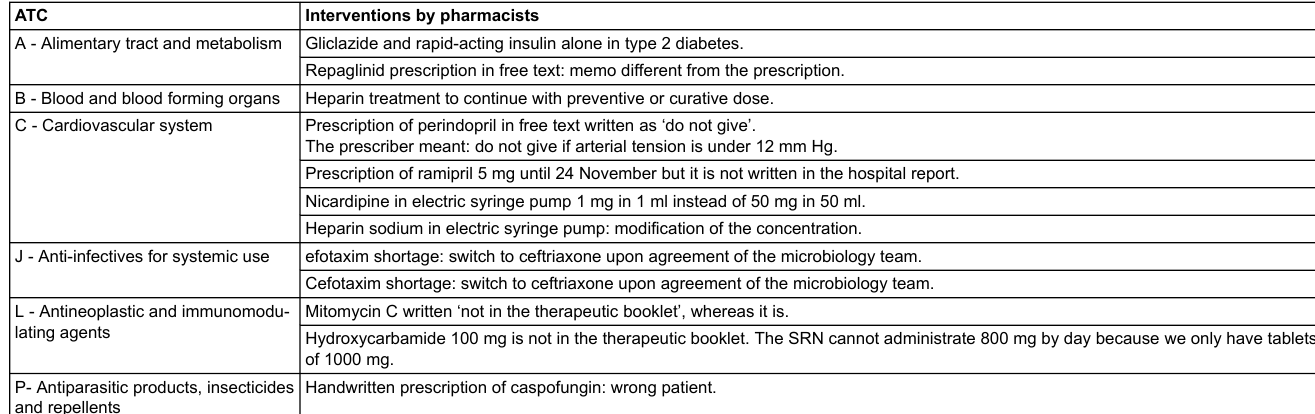
Table S1: The 13 interventions by pharmacists excluded because they were not assessable by the French Society of Clinical Pharmacy tool.